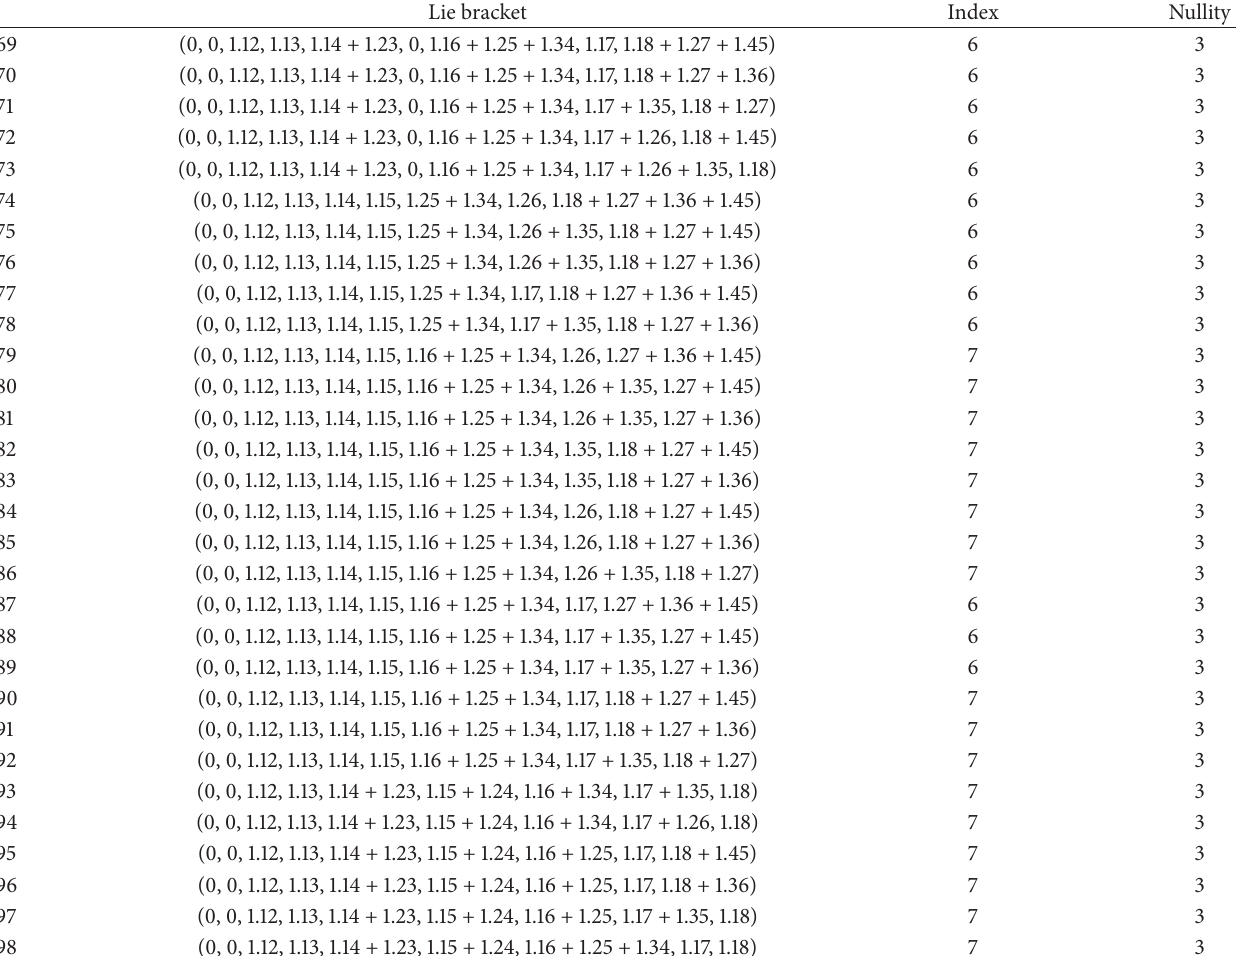
Table 8: The 9-dimensional nilsoliton metric Lie algebra candidates of nullity